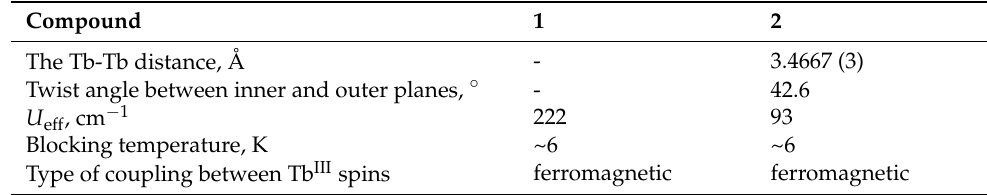
Table 1. Summary of selected structural and magnetic characteristics of samples 1 and 2